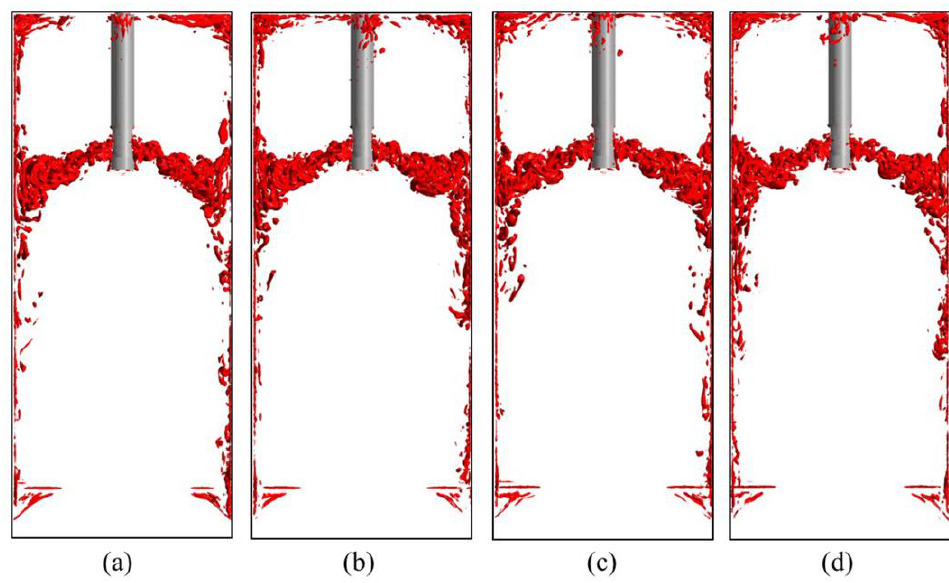
Figure 8. Instantaneous iso-surfaces of the Q-criterion for the case applying EMBr with electrically-conducting walls at: ( a ) 14 s; ( b ) 16 s; ( c ) 18 s; ( d ) 20 s.